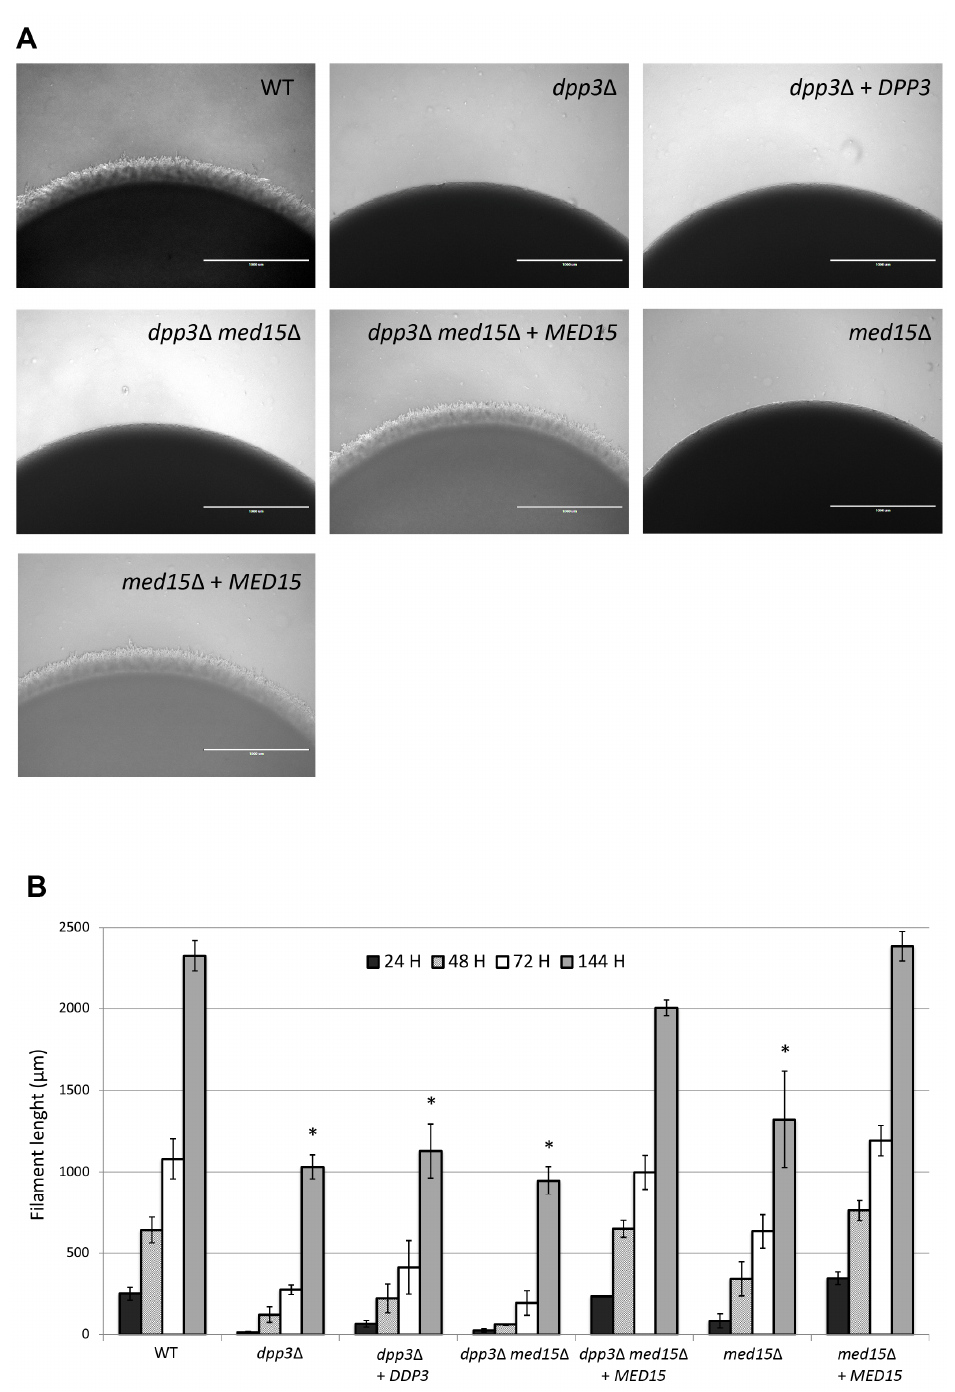
Figure 2. The pseudohyphal growth defect in the dpp3 ∆ mutant is conferred by the med15 ∆ mutation. ( A ) Strains were grown on YCB plates supplemented with uracil at 30 °C. Colony periphery was visualized at 4× magnification under brightfield and photographed after 24 h. Scale bars represent 1 mm. ( B ) Filament length was measured at 24 h, 48 h, 72 h and 144 h using Image J. The average length for one experiment was obtained from 20 measurements for each strain. Results are expressed as mean values ± standard error of data from three independent experiments. Values that are statistically different are marked with an asterisk ( p -value < 0.05). Please refer to Table 1 for detailed strain genotypes. When a WT copy a MED15 was reintegrated into the dpp3 ∆ mutant, pseudohyphal growth returned to wild-type